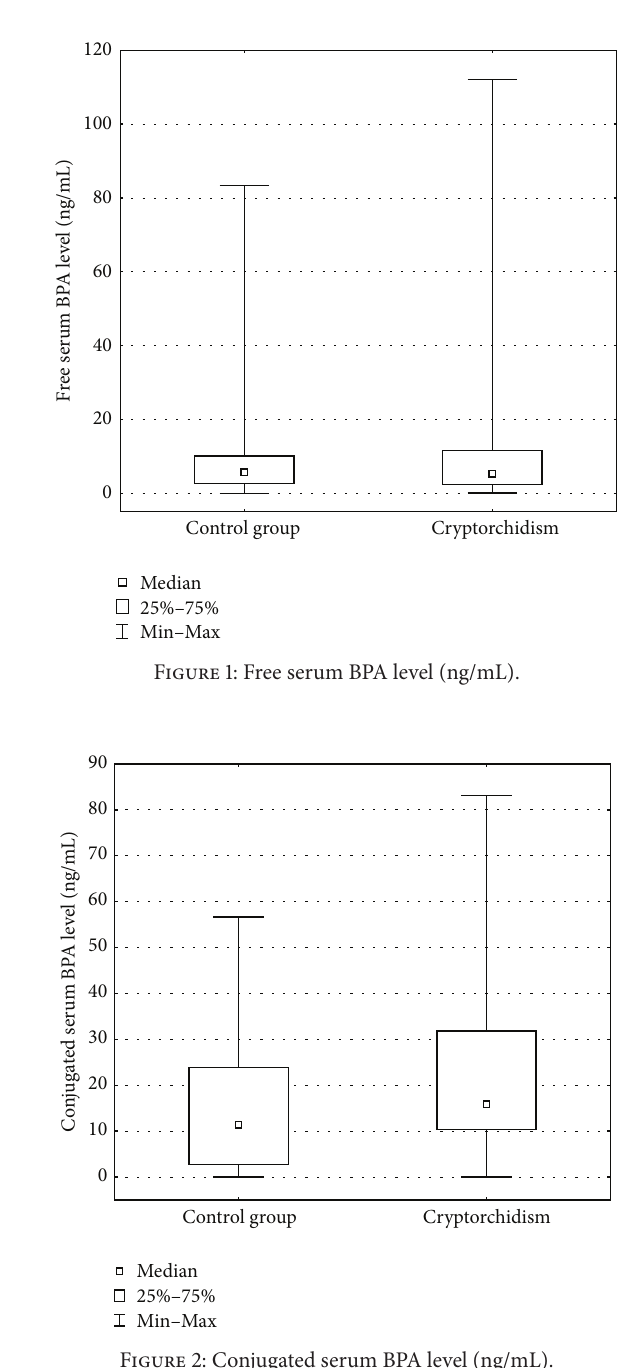
Figure 2: Conjugated serum BPA level